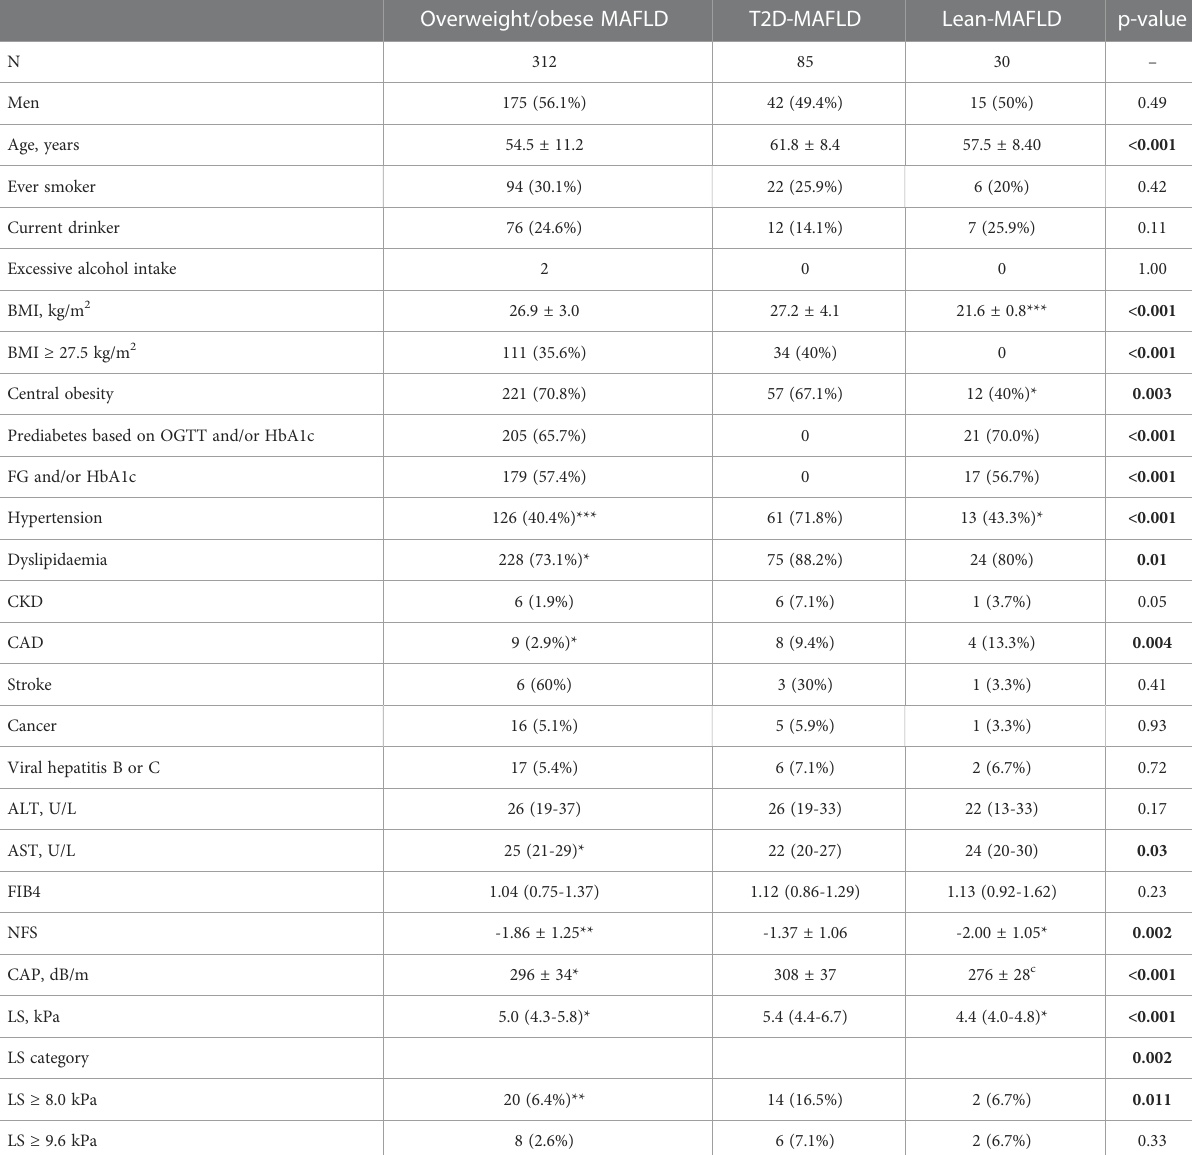
TABLE 1 Clinical characteristics of participants with MAFLD strati fi ed by subtypes (N=427). Overweight/obese